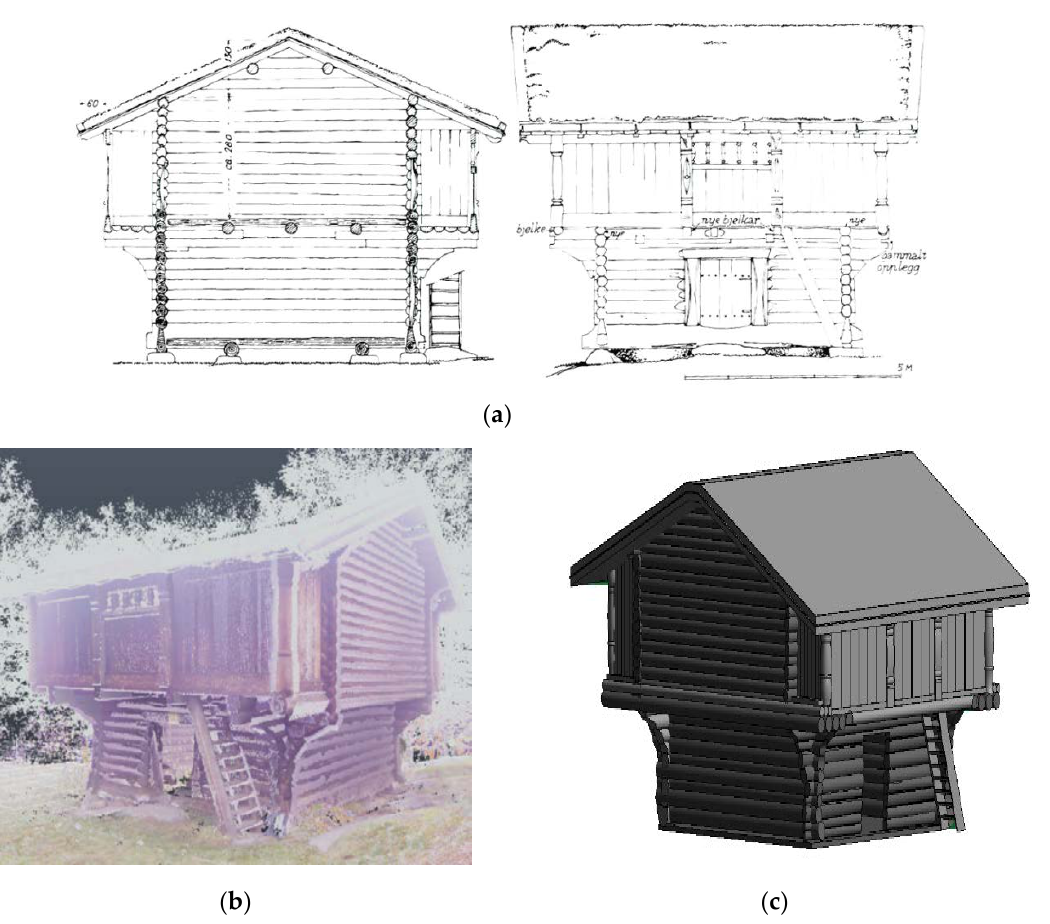
Figure 5. ( a ) Traditional two-dimensional (2D) view, reprinted from [28]; ( b ) Point clouds from three-dimensional (3D) laser scanner; ( c ) 3D drawing view of the Heierstad Loft, Tønsberg, Norway.